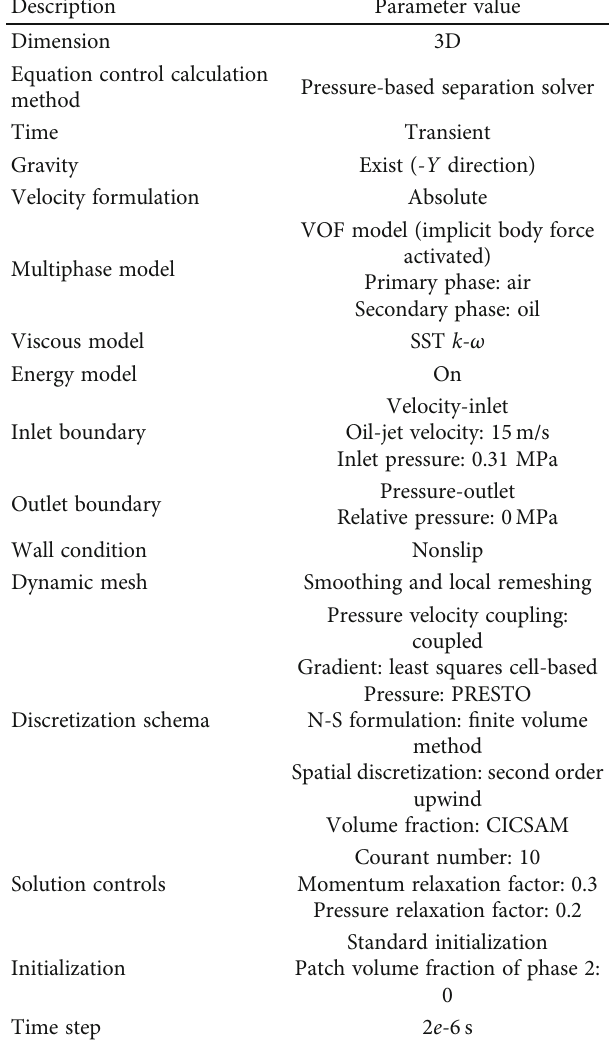
Table 2: Parameters of the numerical calculation